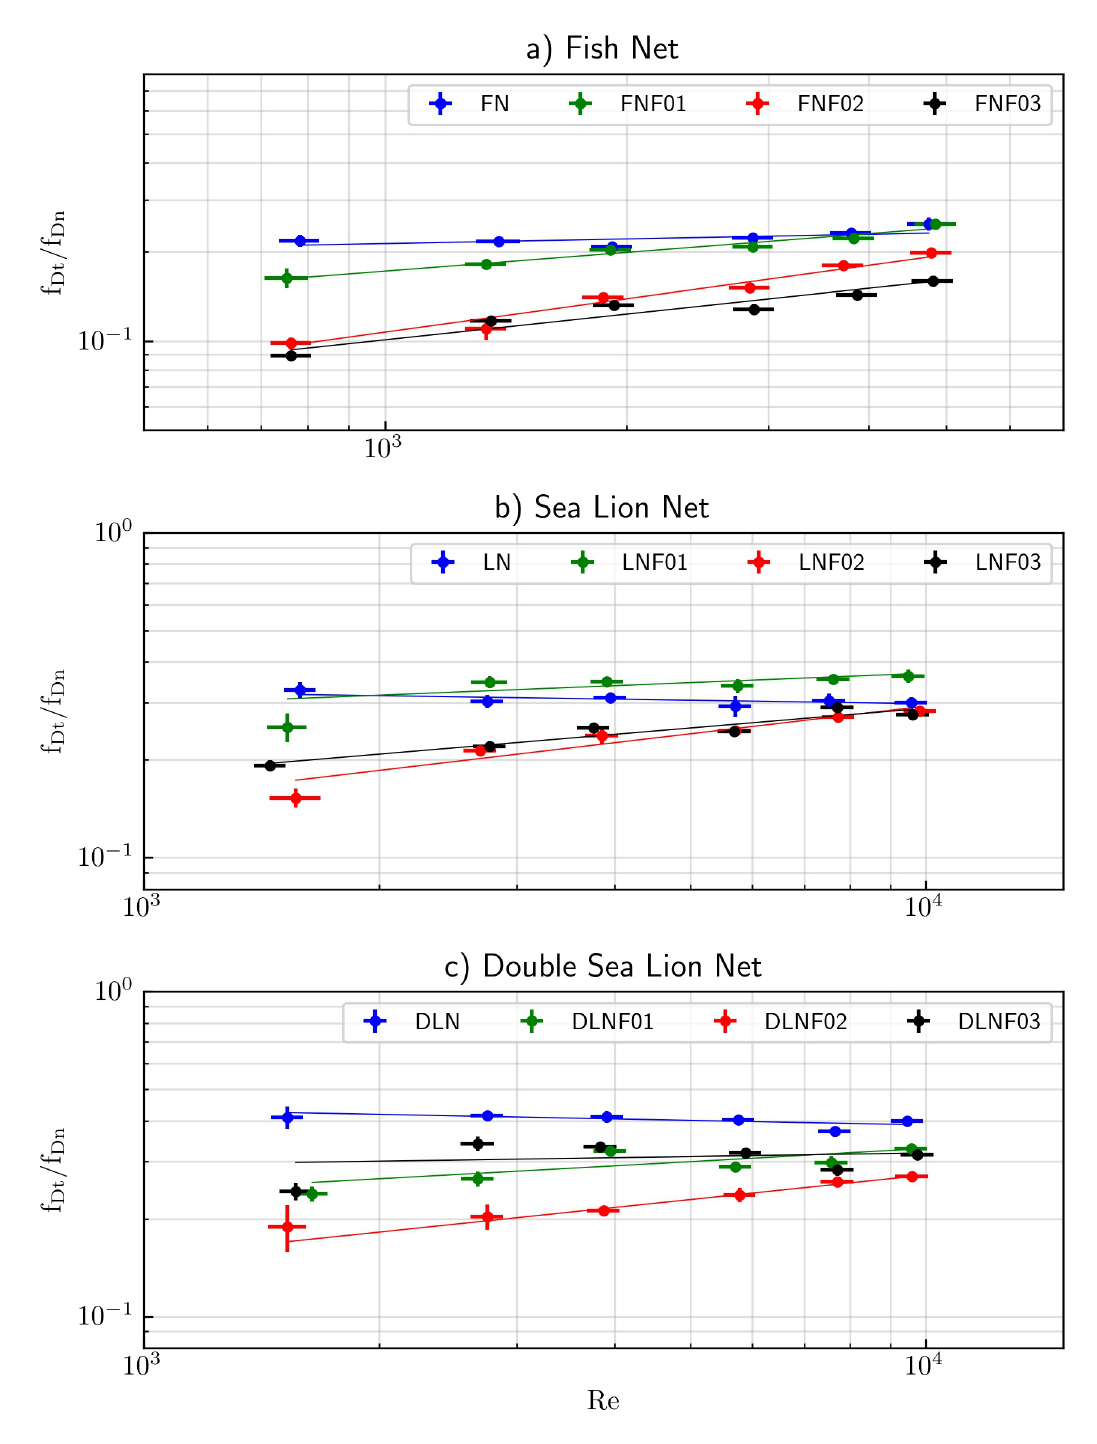
Figure 11. The ratio between the tangential force and the normal drag force for the nets tested versus Reynolds number. Experimental series, clean or without fouling, from Table 1. Lines represent a power law fit of the